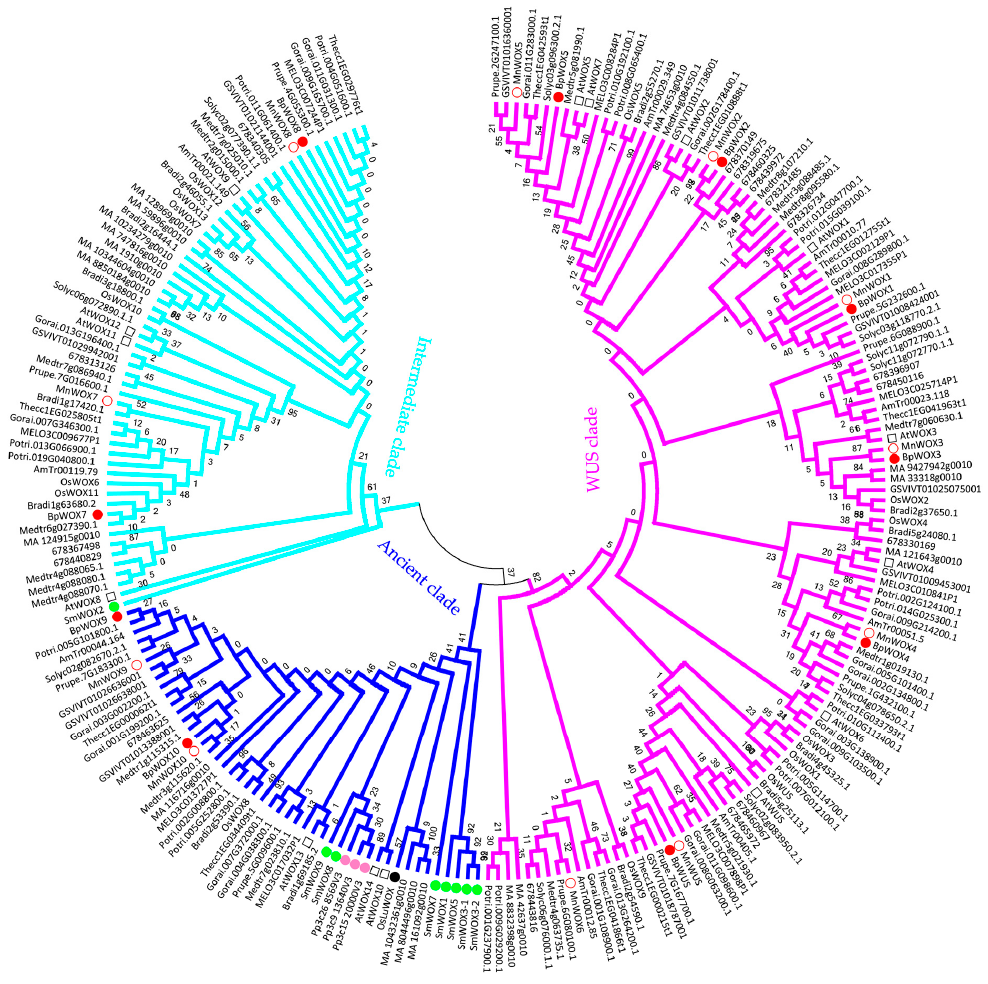
Figure 2. Phylogenetic analysis of plant WOX family. Evolutionary analysis was conducted in MEGA 6.0, and the bootstrap replicates was 1000. A simplified version of the neighbor joining (NJ) tree was displayed, with 228 sequences of proteins from 19 species from green algae to angiosperms. The tree was divided into three clades; the WUS clade, containing 122 sequences, 16 species (pink); the intermediate clade, containing 59 sequences, 17 species (sky-blue); and the ancient clade, containing 47 sequences, 19 species (navy-blue). Two species, O. lucimarinus (black filled circle) and P. patens (pink filled circle) had members only in the ancient clade. S. moellendorffii (green filled circle) had members in both the ancient clade and intermediate clade. Other species had members in all three clades. The paper mulberry (red filled circle) had two members in the ancient clade and intermediate clade, respectively, and six members in the WUS clade. Mulberry is marked with red blank circle, and the A. thaliana is marked by the black blank box. The information of species used in the phylogenetic tree is shown in Supplementary Table S6.